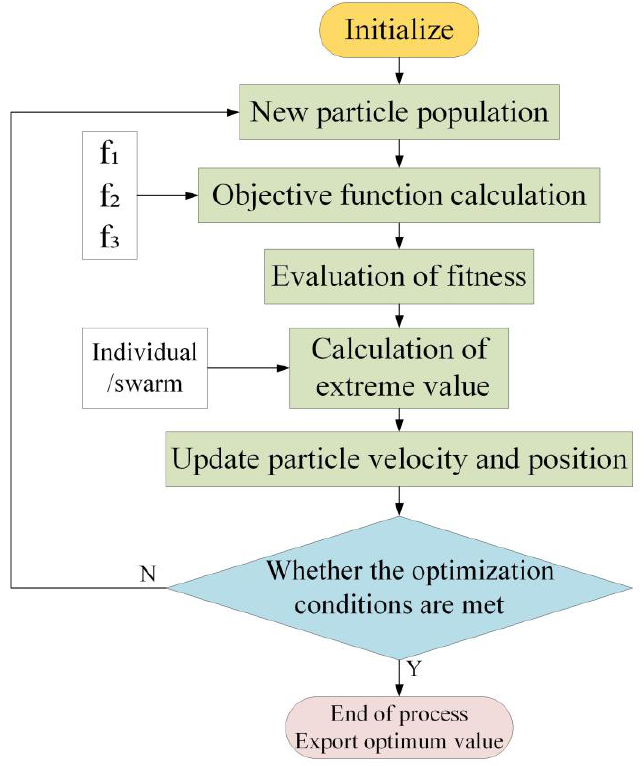
Table 2. Related parameters of the particle swarm optimization algorithm.